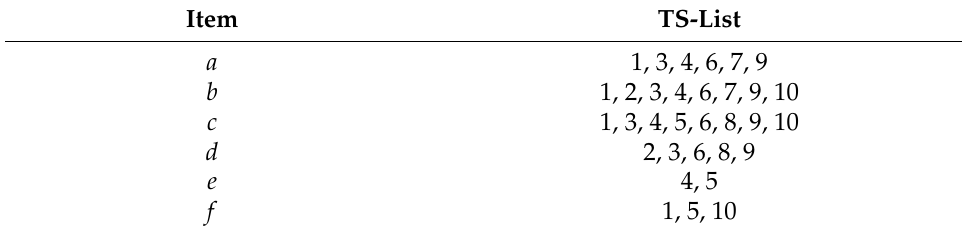
Table 3. List of ts of an